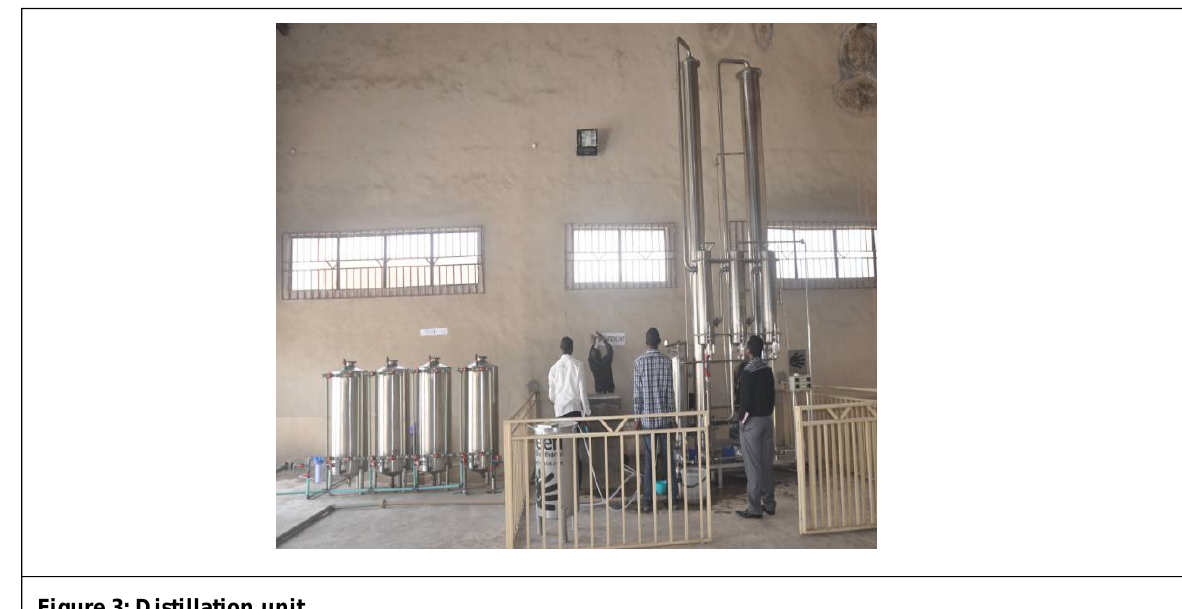
Figure 3: Distillation